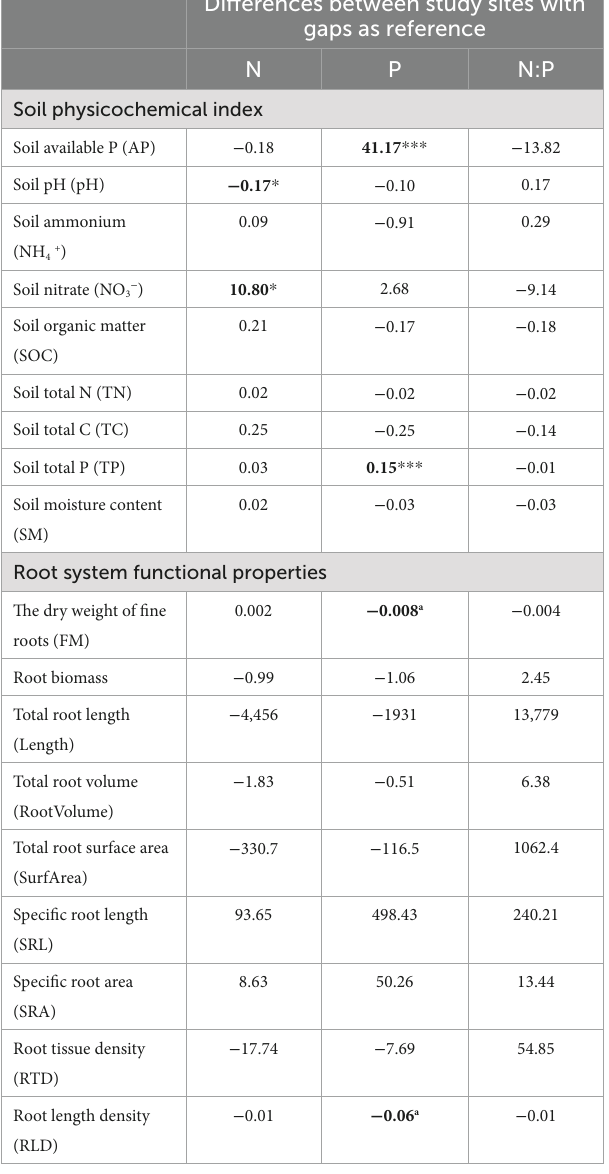
TABLE 1 Effect of fertilizer application on soil nematode and plant diversity. Differences between treatments with blanks as reference